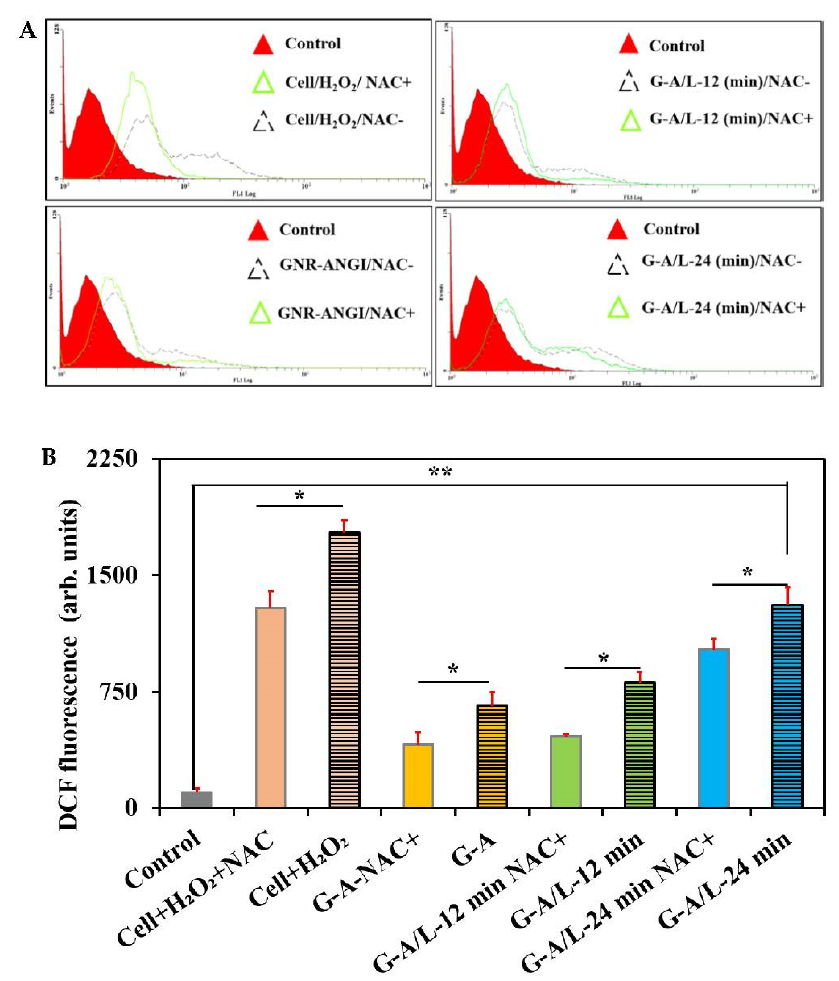
Figure 6. Evaluation of Reactive Oxygen Species (ROS). The fluorescence density of dichlorofluorescin (DCF) was measured via flow cytometry after C6 cells were treated with GNR-ANGI-2 with or without N-acetyl cysteine (NAC) at a concentration of 5 mM under laser or sham exposure with two irradiation time points (12 min or 24 min) and stained with the DCFDA reagent for 20 min. ( A ) Representative histogram of C6 cells with different treatments using flow cytometry. The log fluorescence (X-axis) illustrates the DCF intensity of fluorescence for the number of cells counted. ( B ) The bar graph represents quantified data of fluorescence intensity of DCF, representing a remarkable increase in ROS in G-A/L-24 min. The values are presented as means ± SEMs. ( n = 3; * p <0.05 and ** p